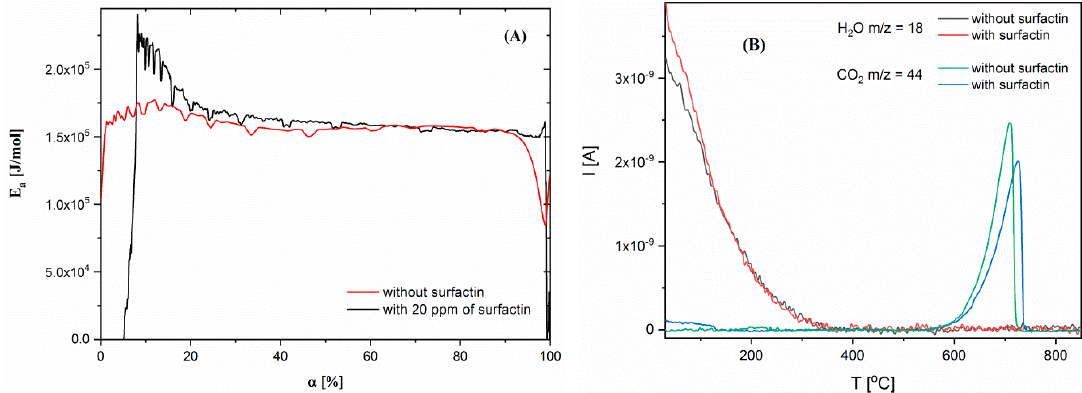
Figure 5. ( A ) E a changes as a function of materials conversion. ( B ) QMID (Quasi Multiple Ion Detection) value for m / z 18 (water) and 44 (CO 2